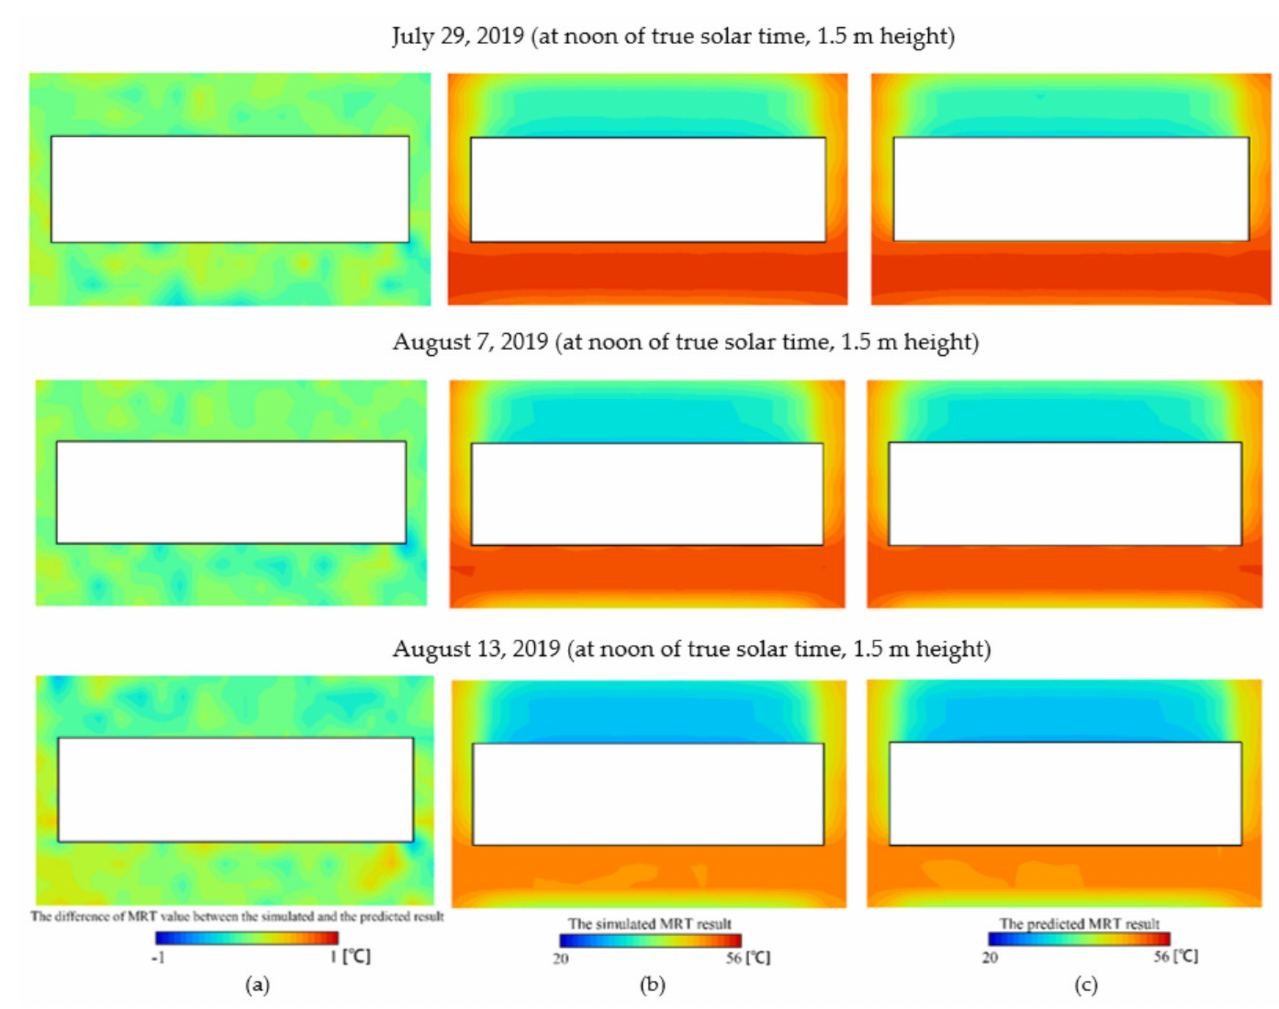
Figure 8. Comparison of the predicted results and calculated results: ( a ) The difference between the simulated results and the predicted results; ( b ) the simulated results; and ( c ) predicted results by the MLNN-GABP neural